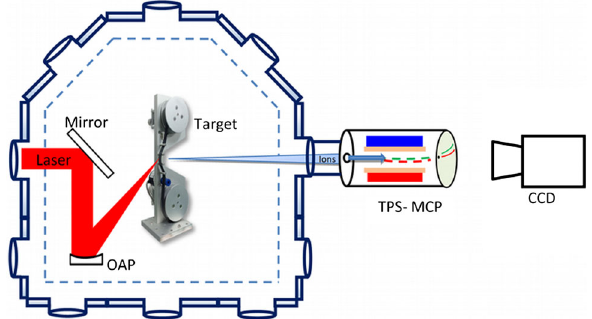
FIG. 4. Schematic of the experimental setup for acceleration for ions in the interaction of intense laser pulses with VHS tape drive target